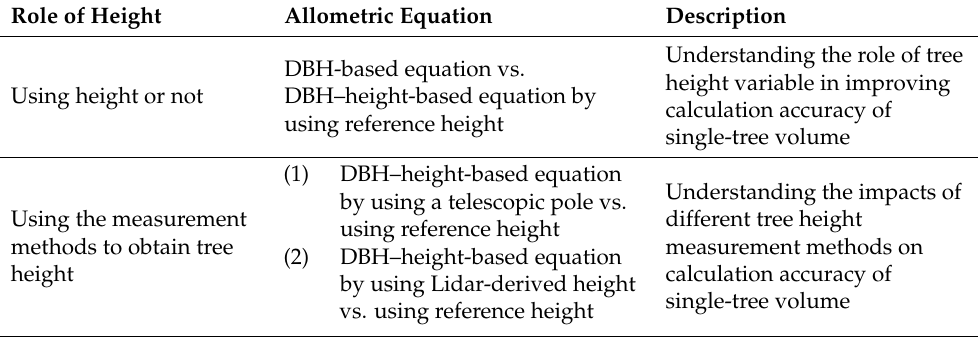
Table 3. Scenarios of examining the role of the tree height variable in calculation of single-tree volume. Role of